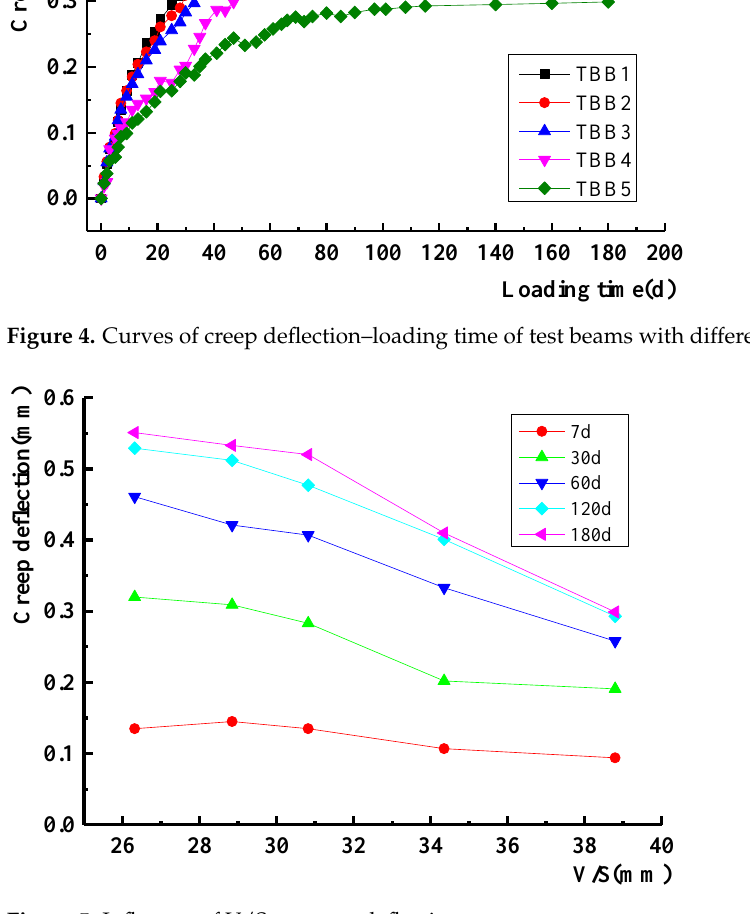
Figure 5. Influence of V/S on creep deflection.